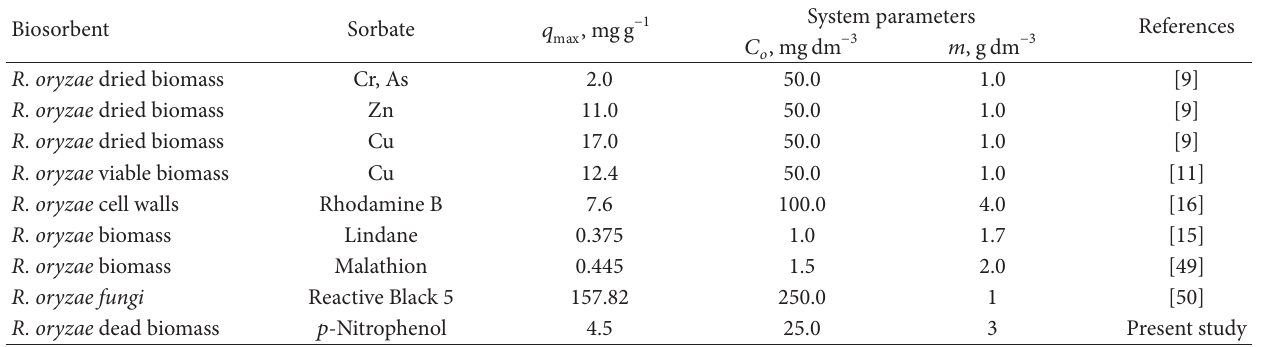
T 5: Biosorption capacities of R. oryzae -based biosorbents towards varous heavy metals and priority organic pollutants.